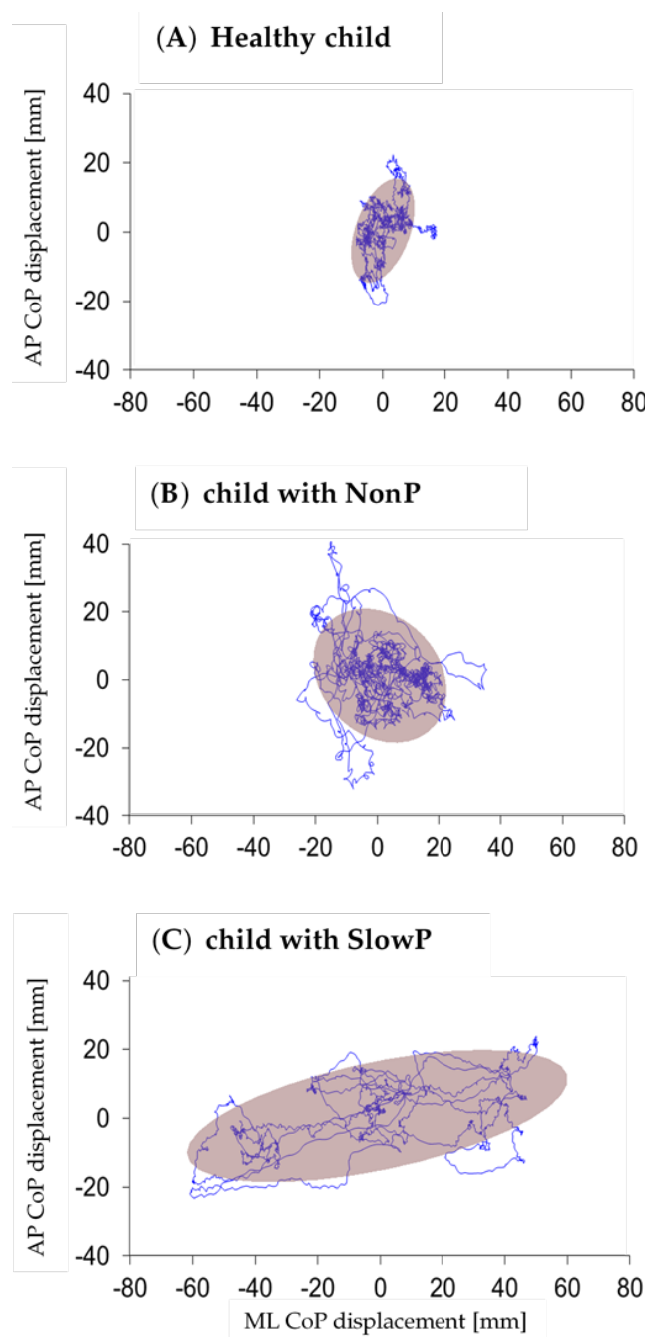
Figure 1. Statokinesigram, with 95% confidence ellipse, for representative children of the three groups: healthy (H, panel A ), with non-progressive PCA (NonP, B ), and with slow progressive PCA (SlowP, C ). ML: mediolateral; AP: anteroposterior; PCA: pediatric cerebellar ataxia.